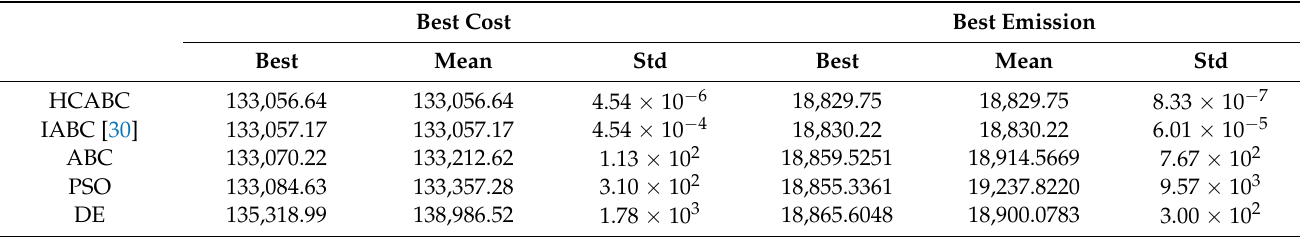
Table 3. Statistical results for case 1 ( P D = 2000 MW ).